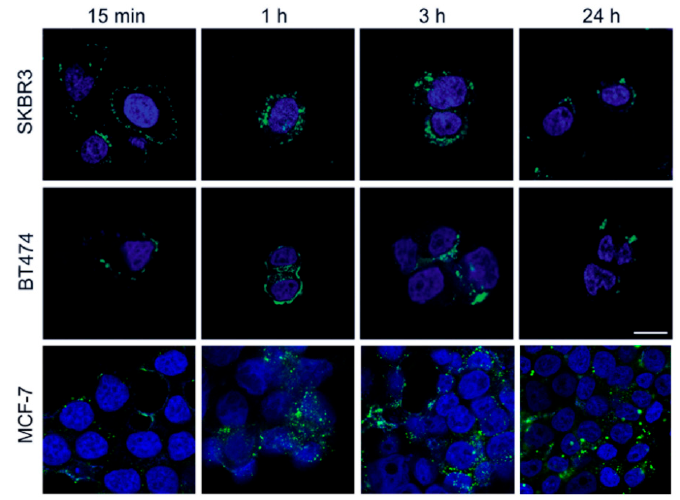
Figure 2. Localization of HFn. Confocal images of SKBR3, BT474, and MCF-7 cells incubated for 15 min, 1 h, 3 h, and 24 h at 37 °C in complete cell culture medium with FITC-labelled HFn nanoparticles (green; 100 µg/mL). Nuclei were stained with DAPI (blue). Scale bar = 10 µm.